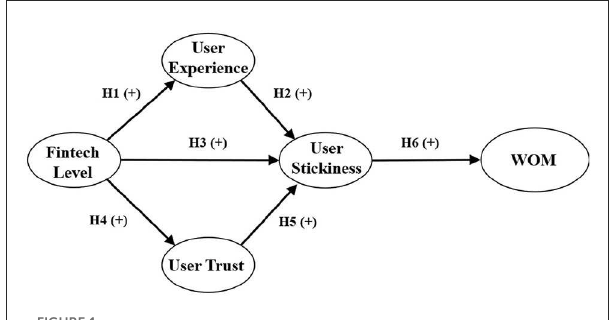
FIGURE1 Theoretical